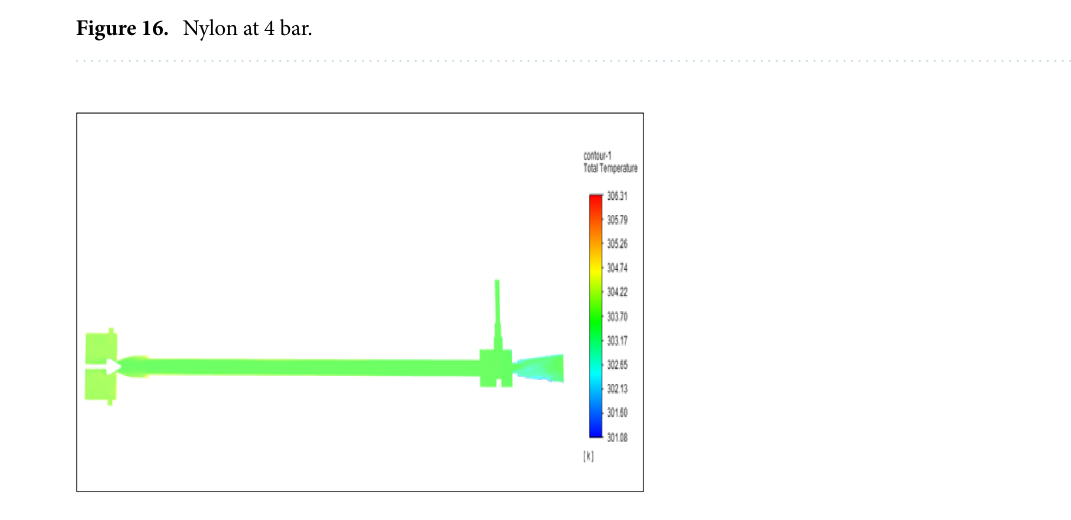
Figure 17. Bronze at 4